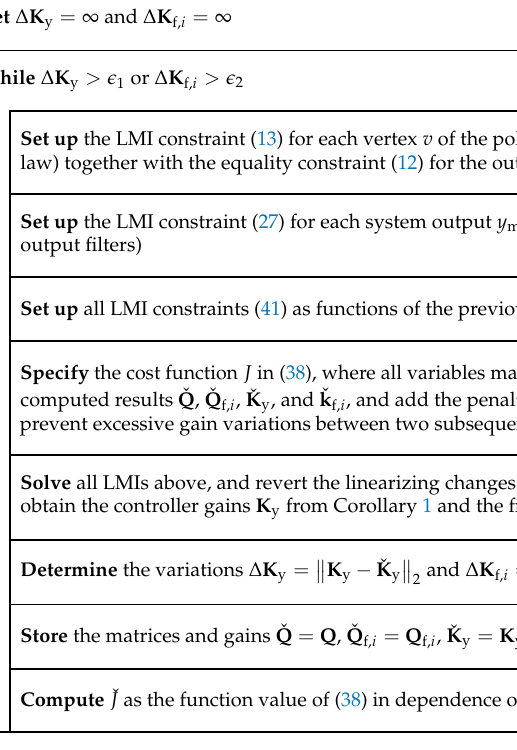
Figure 4. Structure diagram of the iteration procedure for the proposed filter-based control parame-